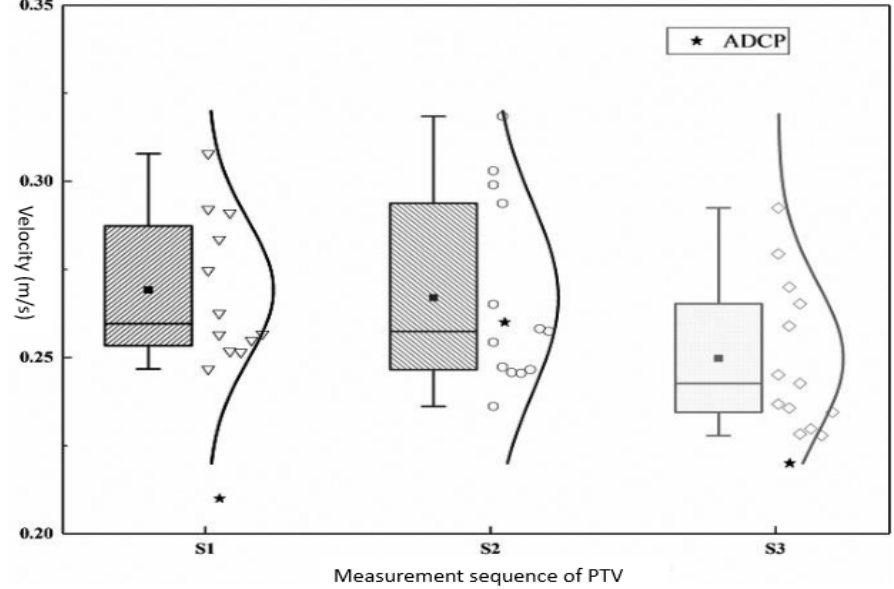
Figure 8. Measurement results of the outdoor experiment.